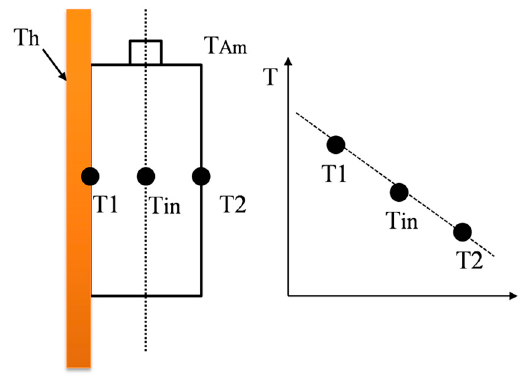
Figure 3. Artificial temperature gradient experiments diagram. Table 3. The artificial temperature gradients.